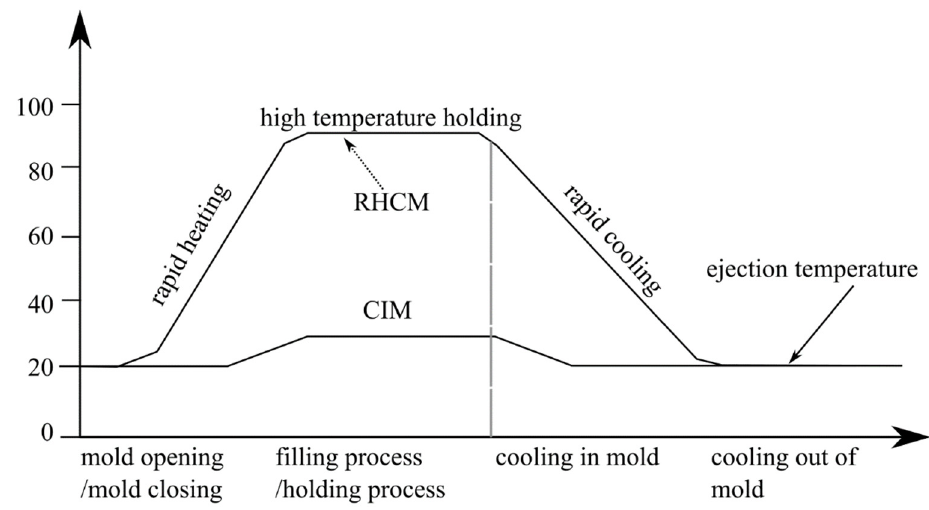
Figure 2. The cycle in the RHCM process [88].